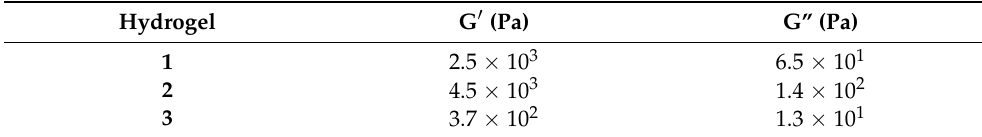
Table 3. G (cid:48) and G” for hydrogel 1 , 2 , and 3 .